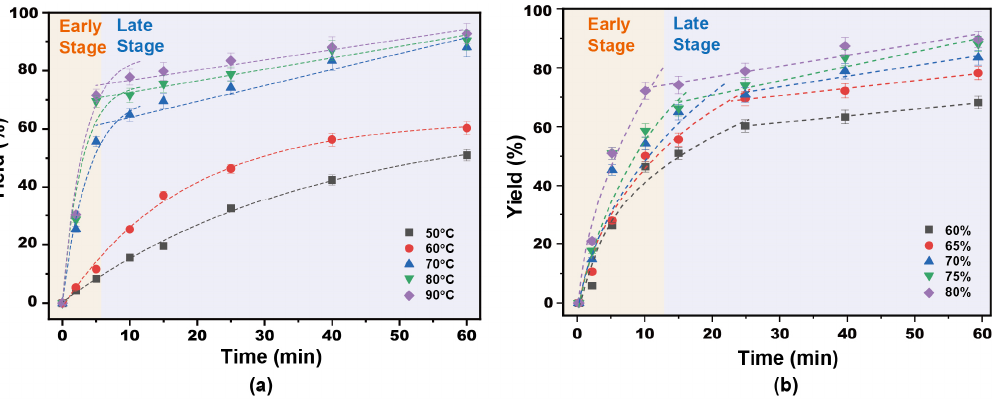
Figure 5. Kinetic fitting curve of lignin separation following p -TsOH treatment: ( a ) Influence of reaction temperature; ( b ) Influence of p -TsOH concentration.